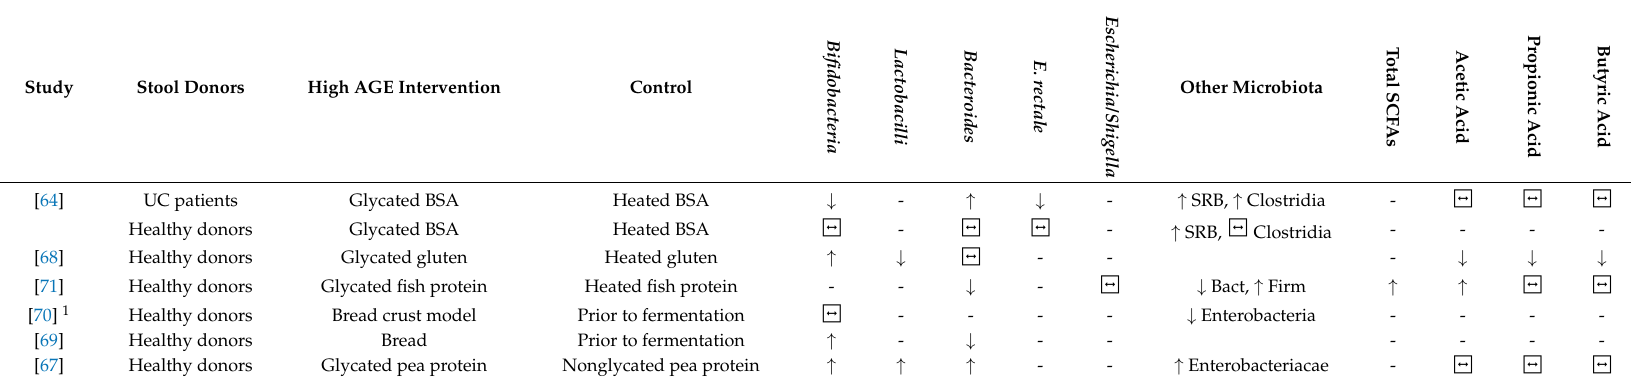
Table 1. Summary of in vitro studies.